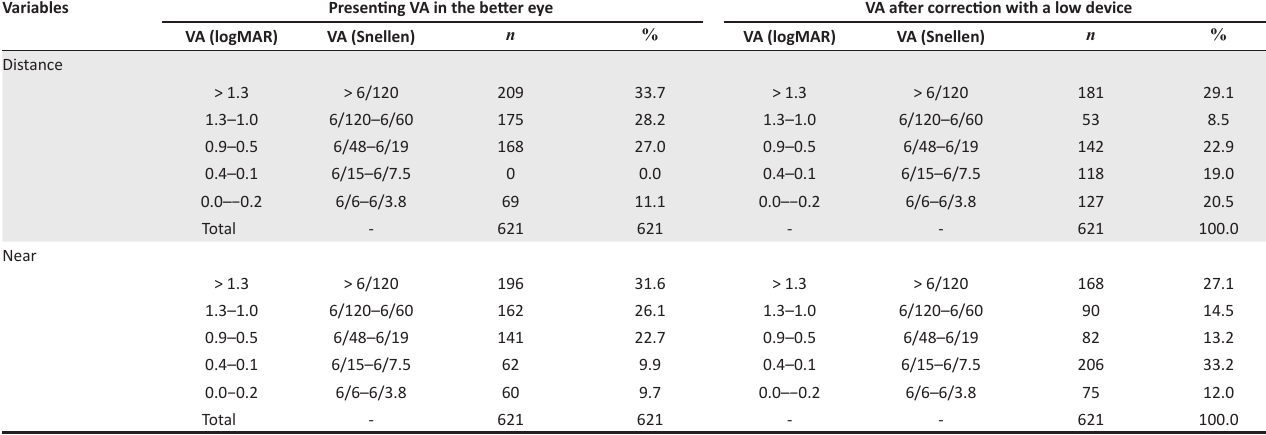
TABLE 2: Presenting visual acuity in the better eye and also after correction with a low vision device. Variables Presenting VA in the better eye VA after correction with a low